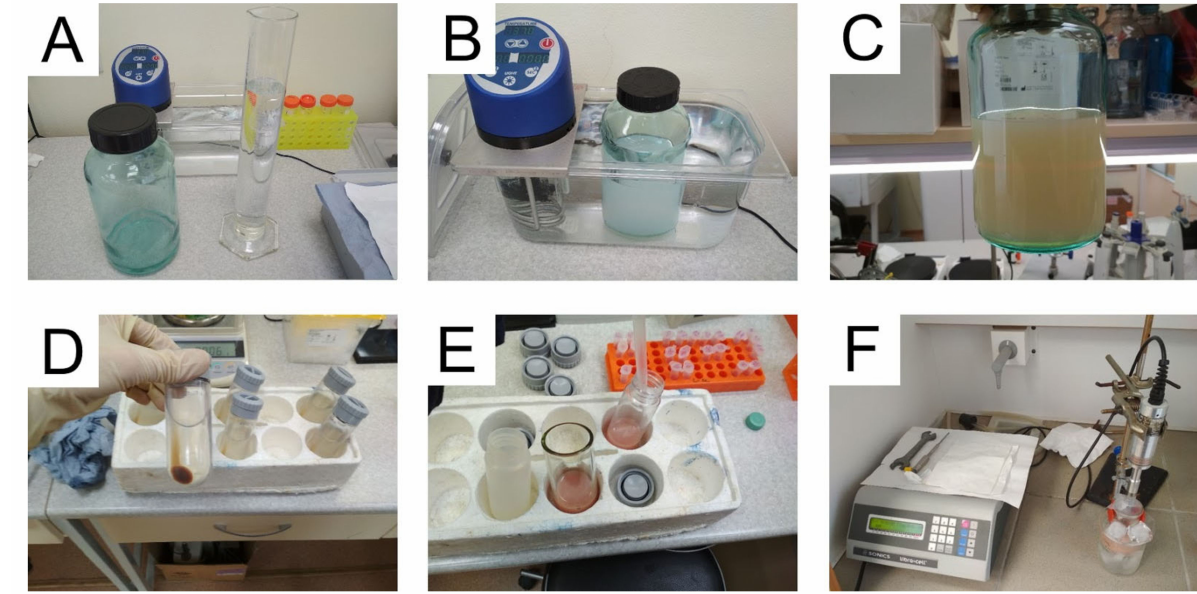
Figure 3. Stages of gelatin nanoparticle synthesis. ( A ) Solution of gelatin and isopropyl alcohol before mixing; ( B ) incubation of nanoparticles at the water bath; ( C ) nanoparticle suspension appearance after glutaraldehyde addition; ( D ) sediment of nanoparticles after centrifugation; ( E ) combining of washed gelatin nanoparticles prior to final sonication; ( F ) sonication of gelatin nanoparticles on